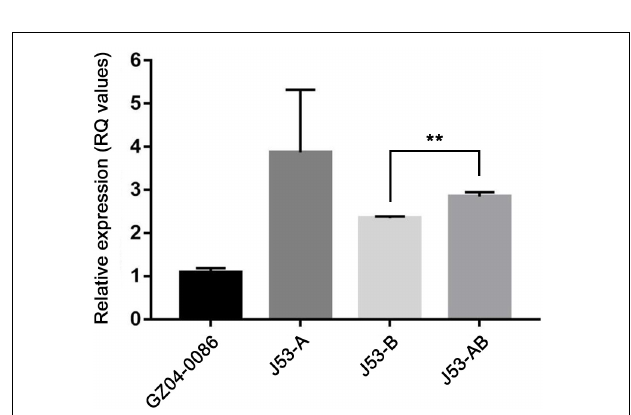
FIGURE 2 | Relative expression of the bla NDM - 5 gene among strain GZ04-0086 and transconjugants J53-A, J53-B and J53-AB. Strain GZ04-0086 was used as the reference. Asterisks above lines indicate a statistically significant difference ( ** P < 0.01) as determined by Student t